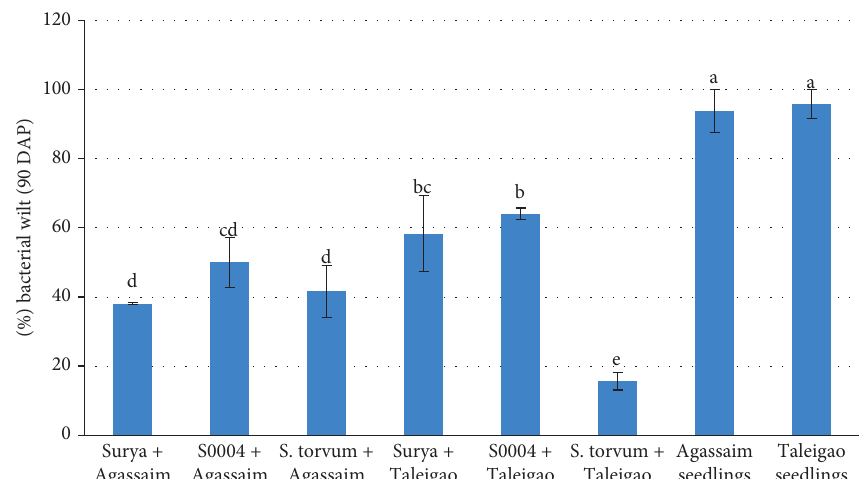
Figure 3: Incidence of bacterial wilt in eggplant grafts on Surya, S0004, and S. torvum ; nongrafted seedlings in the field evaluation at research farm of ICAR-CCARI (Dec 2016). Mean of three replications; each replication consists of 16 plants. Treatments are significantly different at 5% (LSD � 14.16) and at 1% (LSD � 19.59) level. Bar in the column represents the standard error. Wilt % in the column indicated by the same letter are not significantly different at 5%